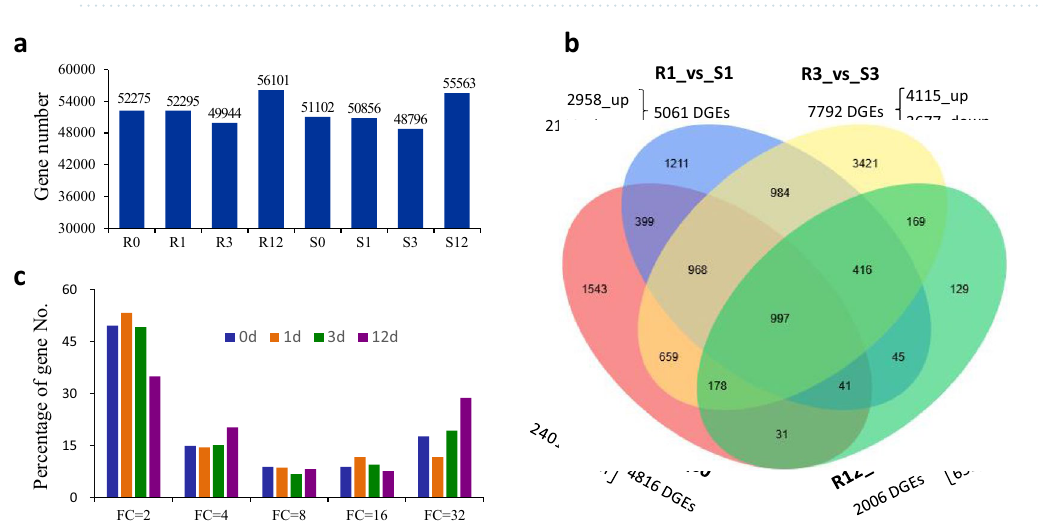
Figure 2. Correlations among the samples between slightly and highly susceptible lines at different timepoints. ( a ) Principal component analysis (PCA) map of the samples; ( b ) Pearson correlation coefficient (PCC) map of the samples. This figure was performed using BMKCloud (www. biocl oud. net).